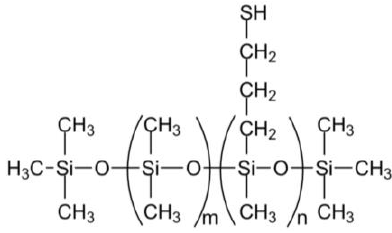
Figure 1. Structure of thiolated poly(dimethylsiloxane) copolymer (T-PDMS). The number of thiol groups per chain, n, is based on the mass average molar weight (M w ) and the percentage of thiol in the T-PDMS. 4 – 6% T-PDMS has a M w range of 6000 – 8000 Da, which corresponds to ranges of m and n values: m= 71 – 94, n= 3 – 6. 13 – 17% T-PDMS has a M w range of 3000 – 4000 Da, which corresponds to ranges of m and n values: m= 30 – 38, n= 5- 8.